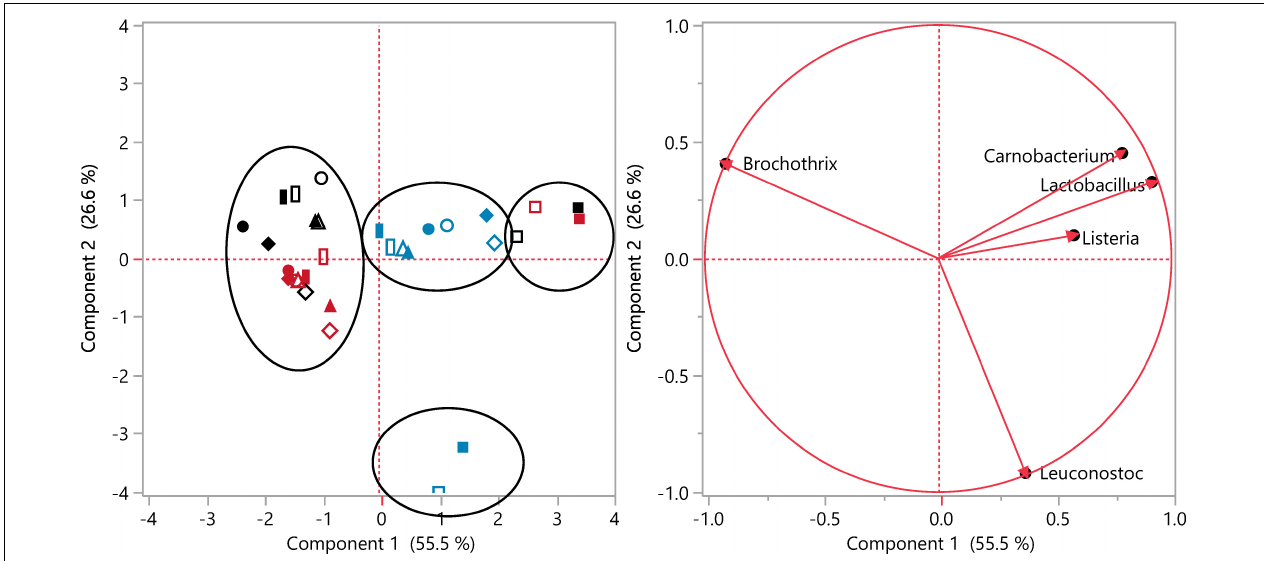
FIGURE 5 | Principal component analysis (PCA) of the % abundance of 16S rRNA sequences on ham containing a nisin preparation, rosemary extract, or without additions after storage for 4 weeks at 4 ◦ C. Ham was inoculated with 5-strain cocktails of L. monocytogenes and RTE meat microbiota, treated for 1 or 3 min at 500 MPa, or left untreated. The percentage of variation explained by the plotted principal coordinates is indicated on the axes. Each symbol represents a type of sample and each color represents a treatment: no addition ( (cid:4) ), or controls with 0.5% ethanol ( • ) or 0.02N HCl ( (cid:78) ), rosemary extract ( (cid:7) ), nisin ( (cid:4) ); no pressure treatment (blue), 1 min at 500 MPa (red), 3 min at 500 MPa